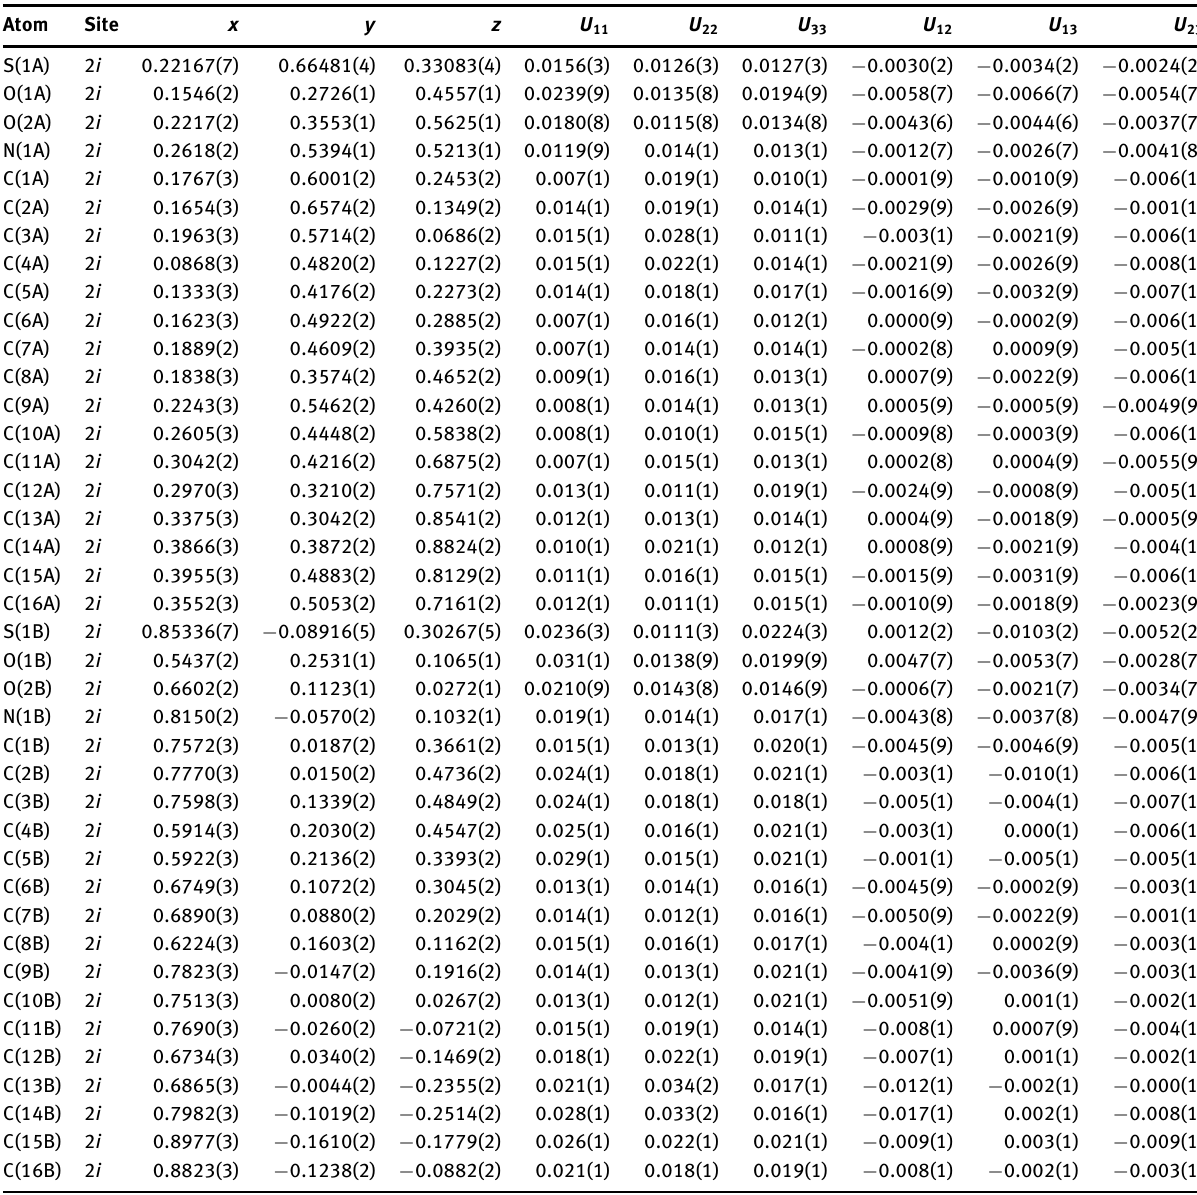
Table 3: Fractional coordinates and atomic displacement parameters (Å 2